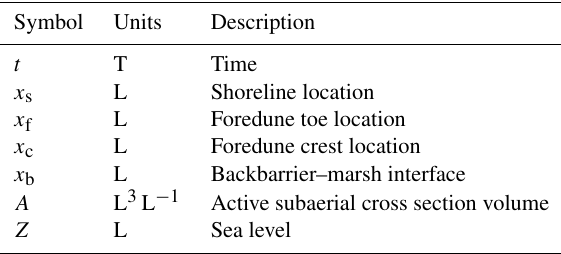
Table 1. State variables for the Subaerial Barrier Sediment Parti- tioning (SBSP) model.